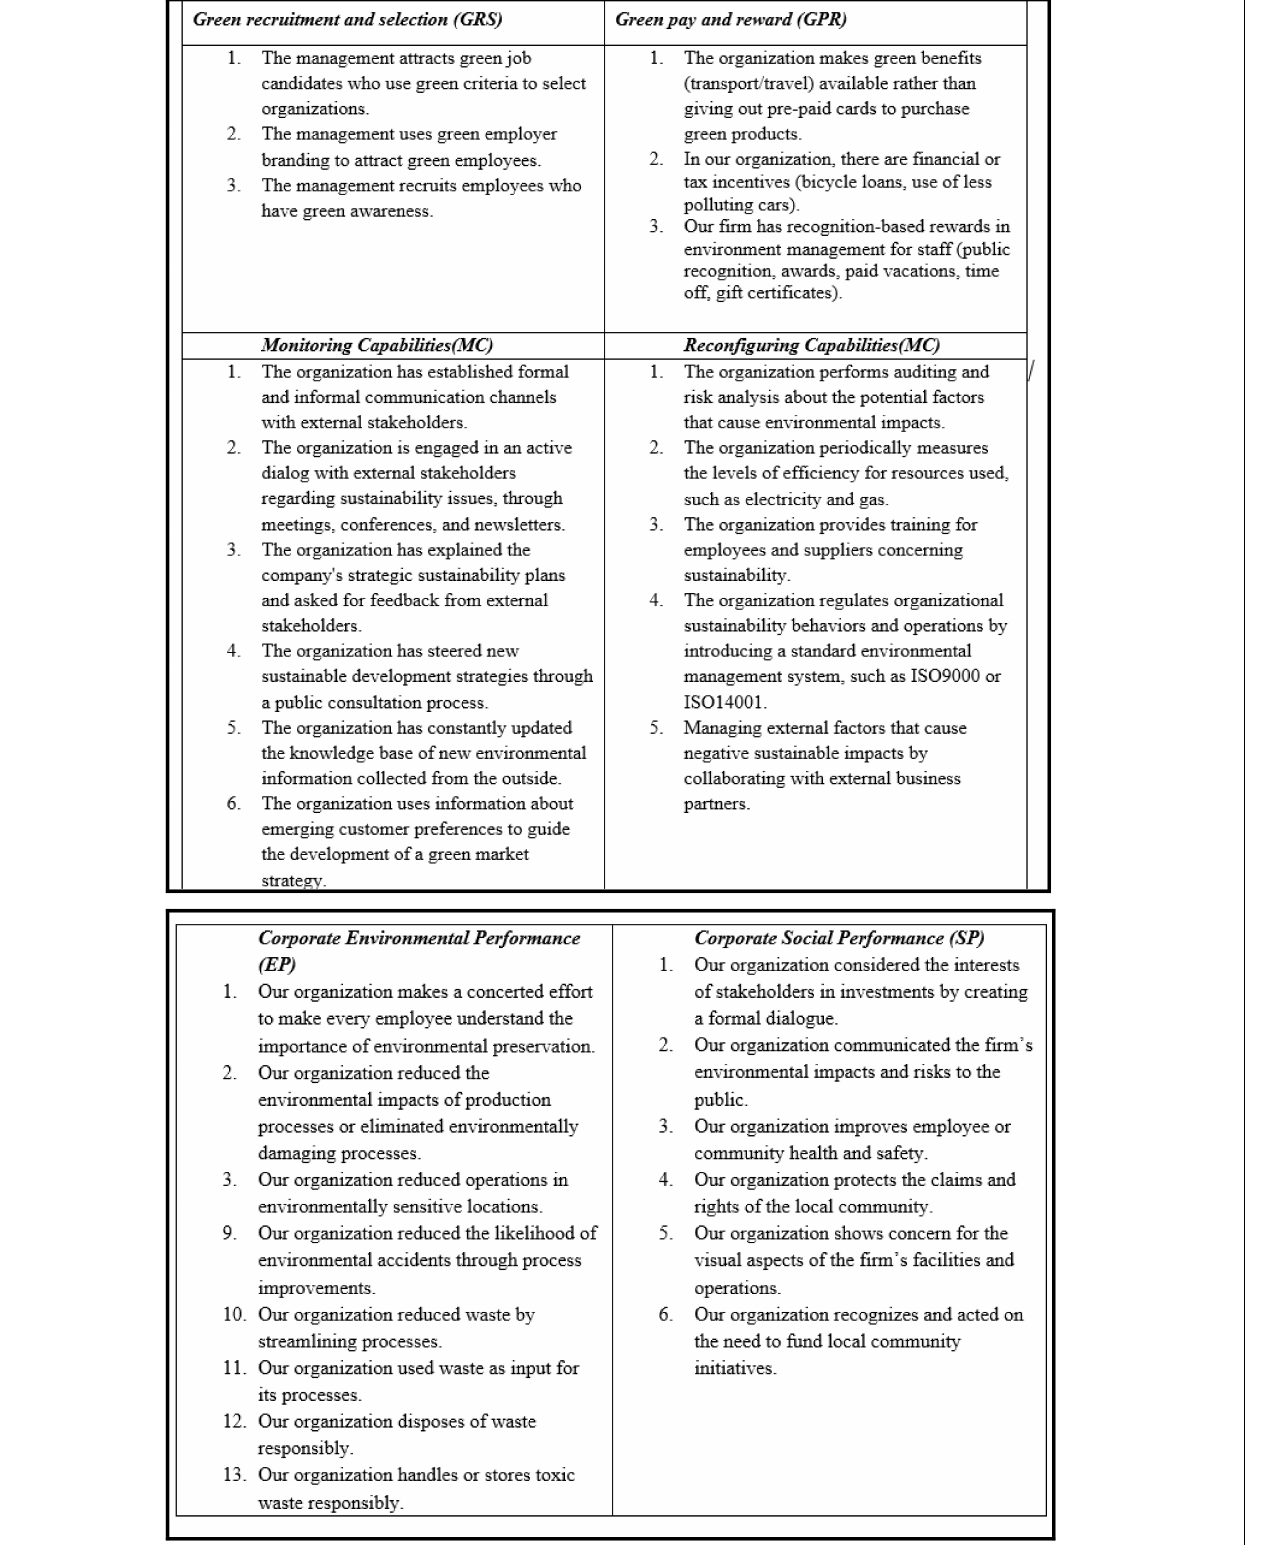
FIGURE 2 | Questionnaire